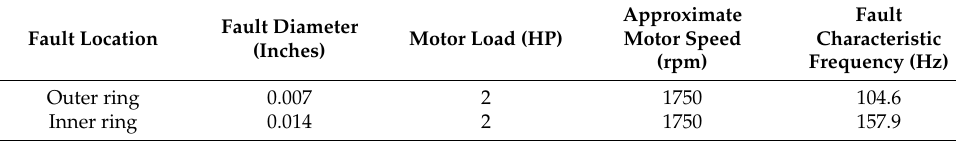
Table 3. The parameters of the faulty bearing.